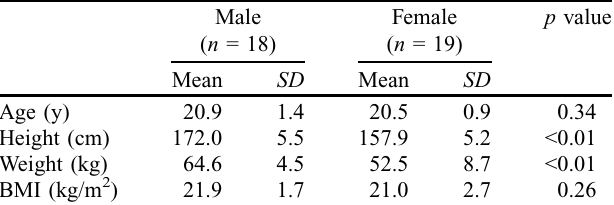
Table 1. BMI = body mass index; SD = standard